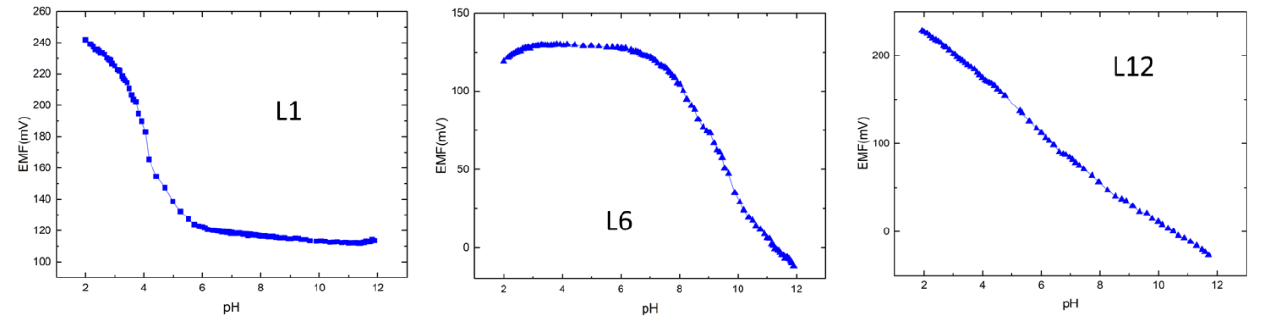
Figure 3. pH-sensitivity of the sensors L1, L6 and L12.